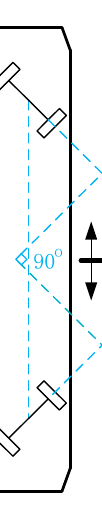
Figure 10. The initial relative angle of front and rear driving units before lifting and laying.